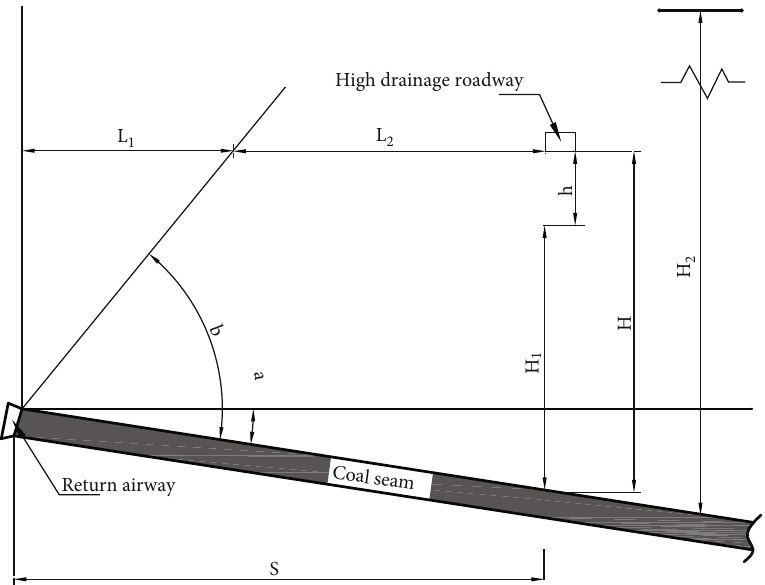
Figure 21: Reasonable level layout of high drainage